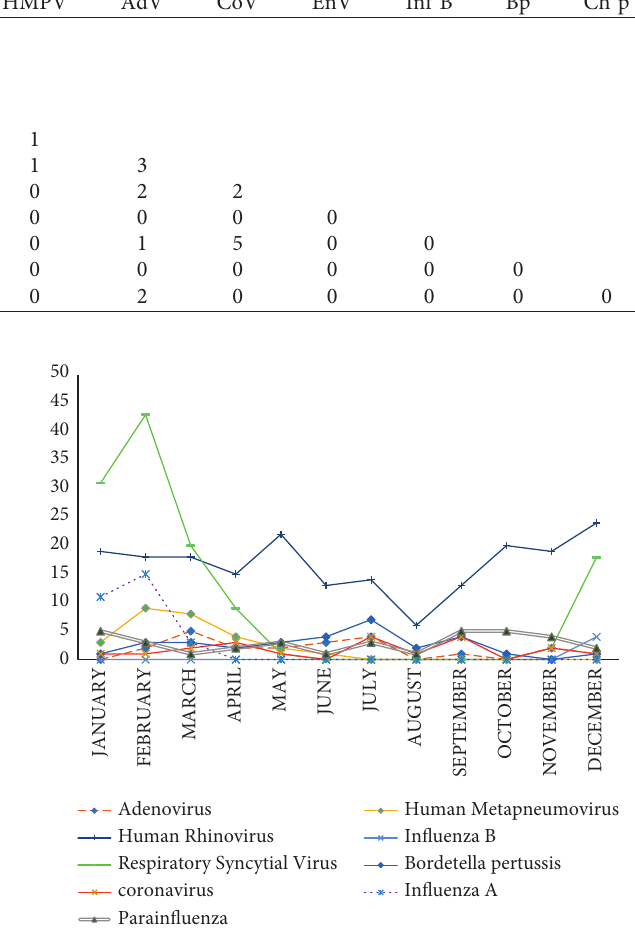
Figure 3: Monthly distribution of respiratory